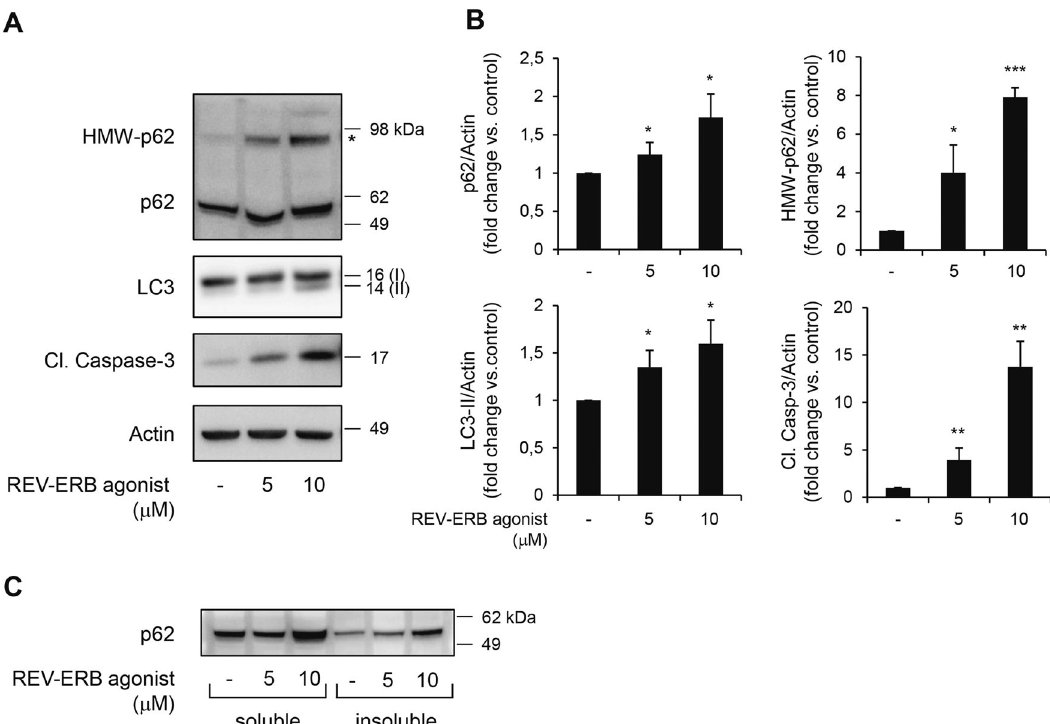
Fig. 2 REV-ERB α agonism inhibits β -cell autophagy and induces β -cell apoptosis. A INS-1E cells were exposed to REV-ERB agonist (SR9009, 5 or 10 μ M, 24 h) or control (vehicle DMSO). Protein levels of p62, high molecular weight (HMW)-p62, LC3, Cleaved Caspase-3, and actin (loading control) were analyzed by western blot. B Graphs represent the quanti fi cation of the blots ( n = 4 – 5 independent experiments). Data are expressed as mean ± SEM; * P < 0.05, ** P < 0.01, *** P < 0.001 vs. control. C Soluble and insoluble fractions obtained from INS-1E cells exposed to REV-ERB agonist (SR9009, 24 h) or control (DMSO). Protein levels of p62 were analyzed by western